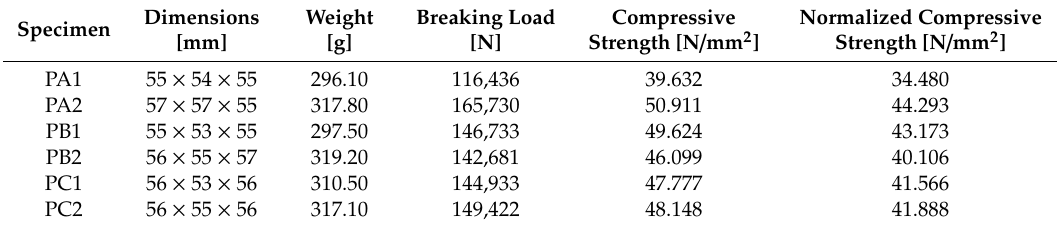
Table 1. Characteristics of the six brick specimens tested in uniaxial compression (UNI EN 772-1) [1].